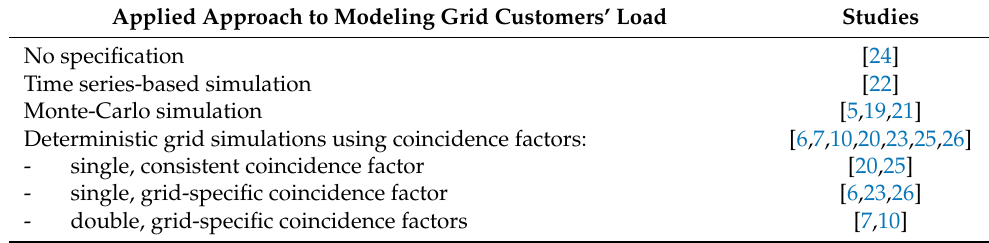
Table 2. Classification of recent studies according to their approach to modeling grid customers’ load.